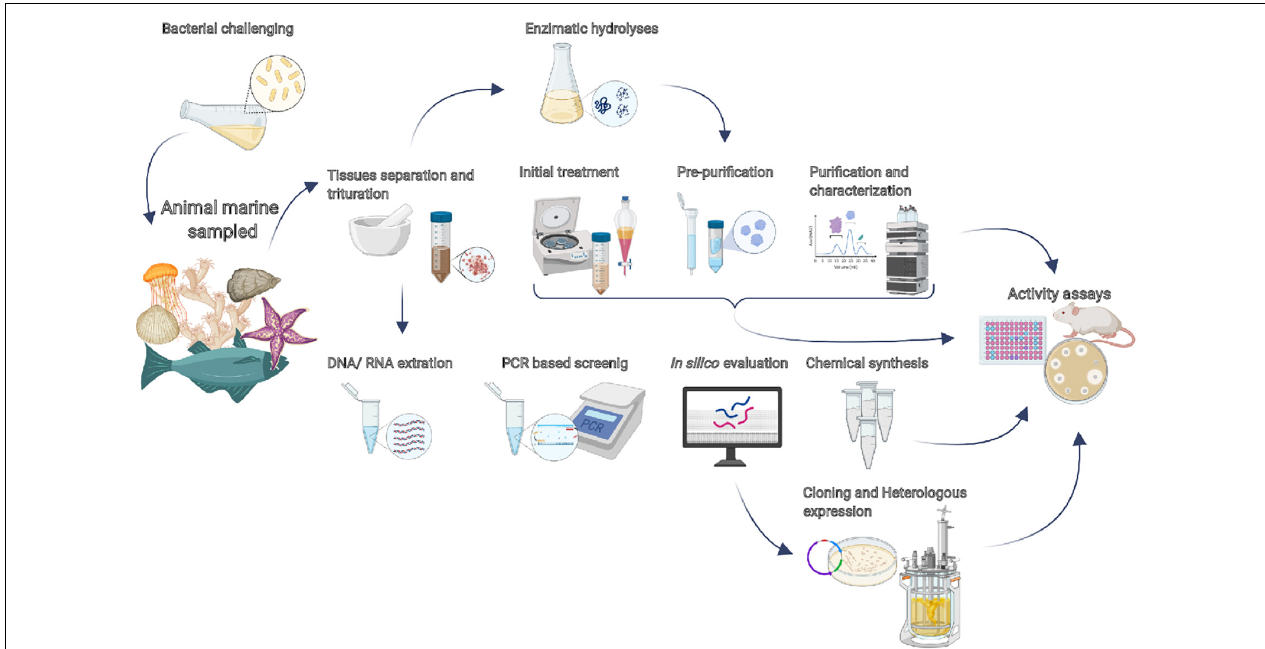
FIGURE 2 | Current strategies for prospecting bioactive peptides from marine organisms. A basic approach is the separation and trituration of the tissues, followed by initial treatment (organic extraction, concentration, and/or partitioning). The pre-purification step may employ size exclusion chromatography, ion-exchange chromatography, and/or solid-phase extraction. All those steps can be guided by activity assays. RP-HPLC is typically used as a final purification step for obtaining the purified peptide that will be able to be characterized. Alternatively, after tissue separation, enzymatic hydrolysis could be employed to prospect bioactive peptides encrypted into proteins. Additionally, the search for bioinspired sequences is performed with PCR-based screening. The bacterial challenge consists of submitting the organisms to pathogenic bacteria, which promote the production of